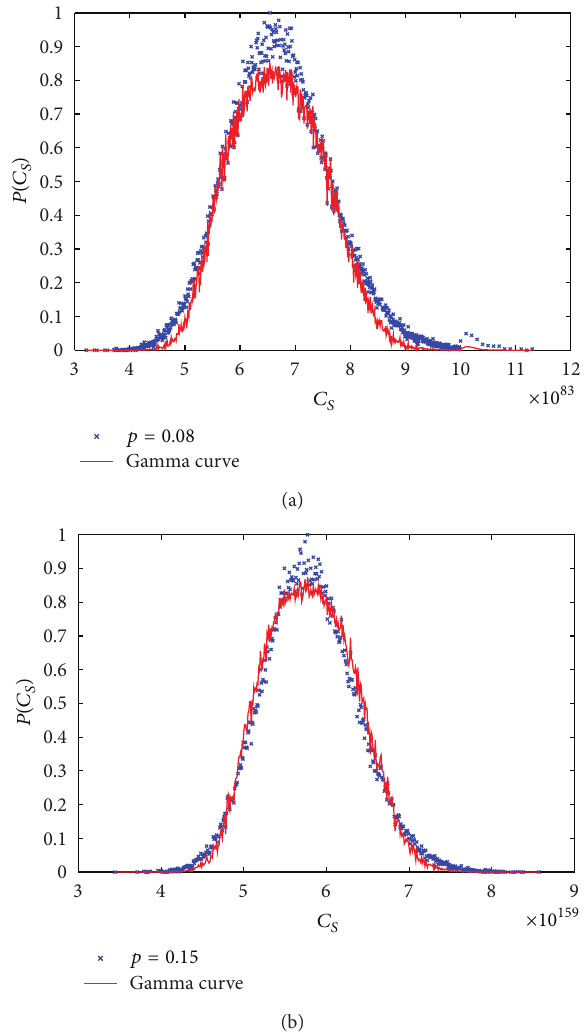
Figure 8: Probability distributions of subgraph centrality 𝑃(𝐶 𝑆 ) and the fitting curve of gamma distribution for the ER network model. (a) 𝑃(𝐶 𝑆 ) for 𝑁 = 2500 and 𝑝 = 0.08 , gamma distribution with ) for 𝑁 = 2500 and 𝑝 = 0.15 , 𝛼 = 2.07 and 𝛽 = 0.28 . (b) 𝑃(𝐶 𝑆 gamma distribution with 𝛼 = 1.74 and 𝛽 = 0.31 . All networks have 𝑁 = 2500